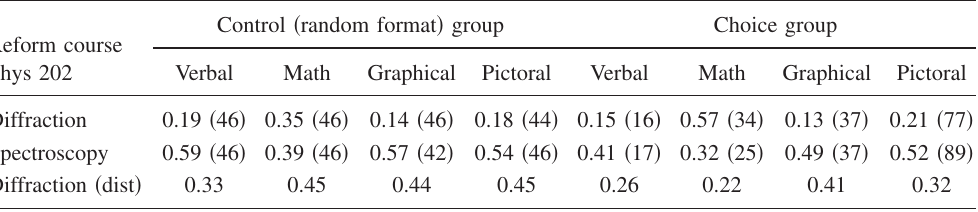
TABLE III. Quiz performance of students from the random-format recitation sections (cid:1) left (cid:2) and from the recitation sections that had a choice of formats (cid:1) right (cid:2) . The number of students taking a quiz is in parentheses. The quiz topics are diffraction and spectroscopy. Standard errors of the mean range from 0.05 to 0.09 and are not shown. The last line indicates how many students chose a particular distractor on the diffraction quiz, as discussed in the text.